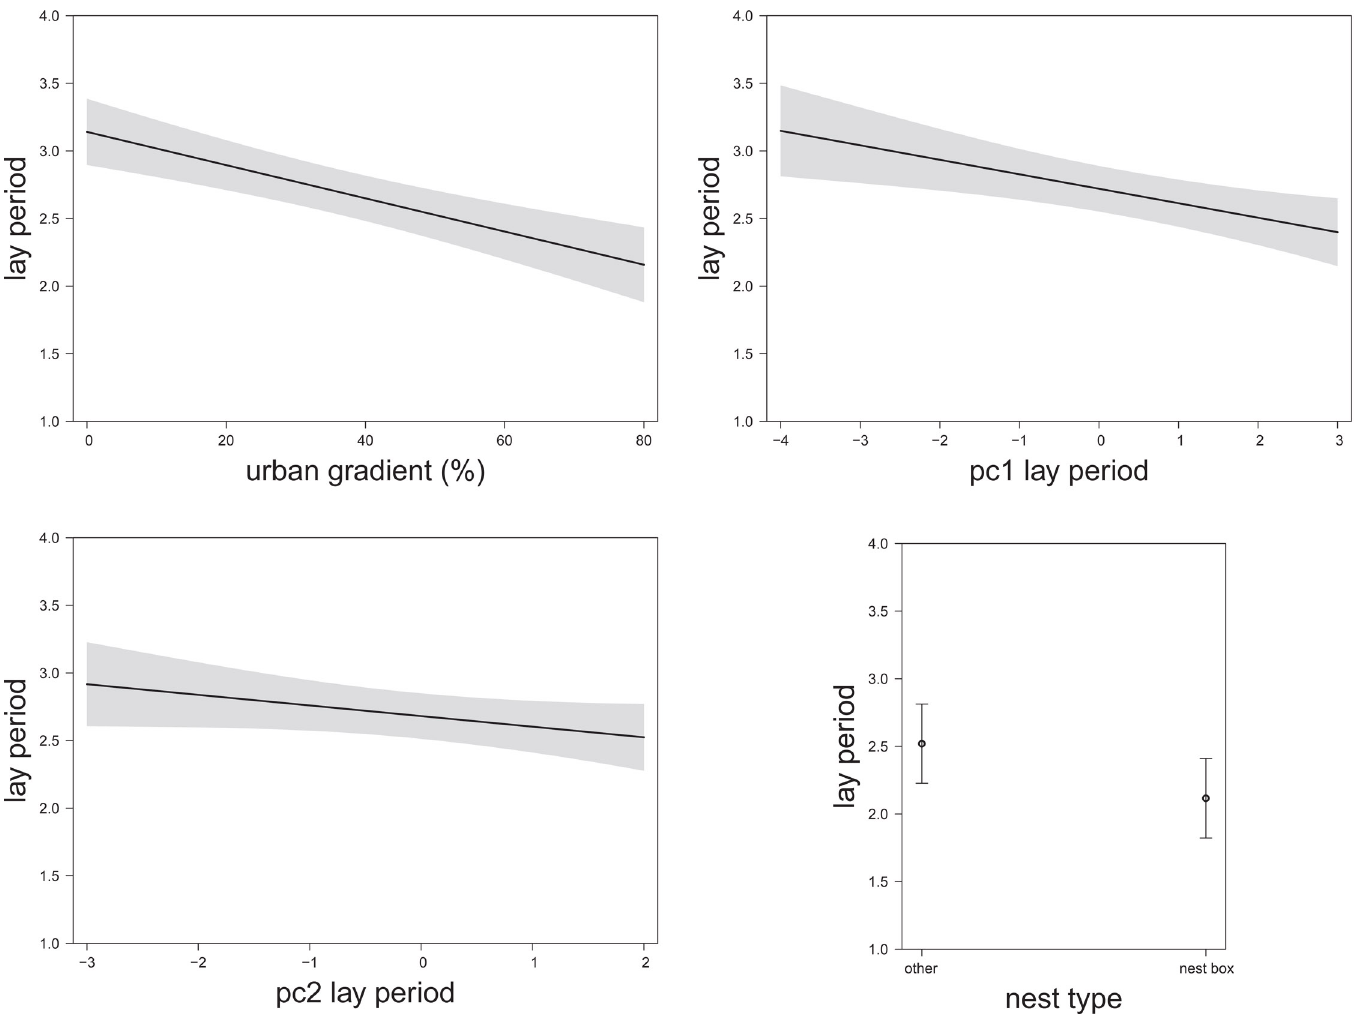
Fig 3. The relationship between the timing of breeding (lay period) and (a) the urban gradient (estimate -0.34 ± 0.07 SE, χ 2 (n = 399) = 23.31, P < 0.001); (b) temperature and rainfall pc1 (estimate -0.11 ± 0.05 SE, χ 2 (n = 188) = 5.69, P = 0.017) [negative values: cold and wet weather conditions; positive values: warm and dry weather conditions]; (c) temperature and rainfall pc2 (estimate -0.13 ± 0.06 SE, χ 2 (n = 188) = 5.20, P = 0.023) [negative values: warm and wet weather conditions; positive values: cold and dry weather conditions]; and, (d) nest type (nest box versus other, urban subset with urban gradient > 40% urban cover; estimate -0.41 ± 0.20 SE, χ 2 (n = 188) = 4.33, P = 0.037) during the egg-laying period based on predicted values of LMM, 95% CIs in shaded grey. Model details in Table 2.